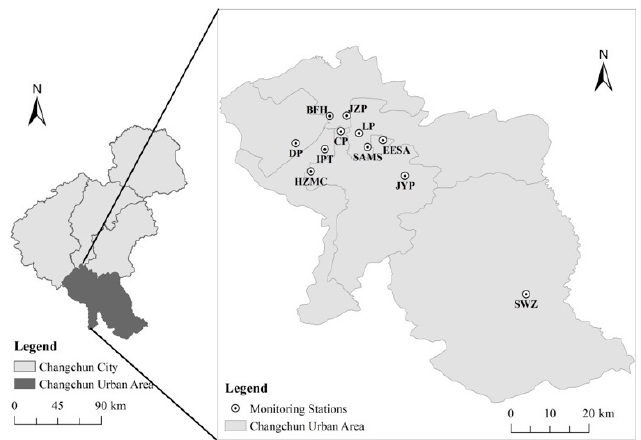
Figure 1. Air monitoring stations of Changchun. Table 1. Sampling stations in Changchun.